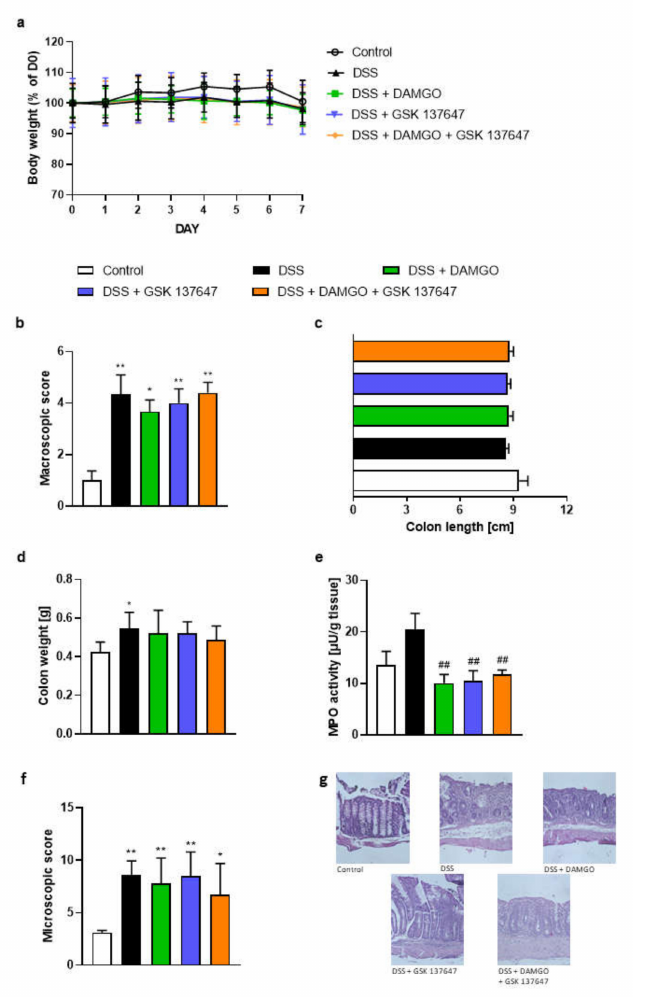
Figure 4. The i.p. administration of MOR agonist DAMGO (0.02 mg/kg BW) and FFAR4 agonist colitis in mice. Figure shows data for body weight loss ( a ), macroscopic score ( b ), colon length ( c ), colon weight ( d ), MPO activity ( e ) and microscopic score ( f ). Representative photos of hematoxylin and eosin staining of colon samples ( g ). Scale bar = 100 µ m. * p < 0.05, ** p < 0.01 as compared to control mice, whereas ## p < 0.01, as compared to DSS-treated mice. Data represent mean ± SEM of 5–10 mice per group. Abbreviations: DSS—dextran sulfate sodium, FFAR4—free fatty acid receptor type 4, i.p.—intraperitoneally, MOR— µ opioid receptor,